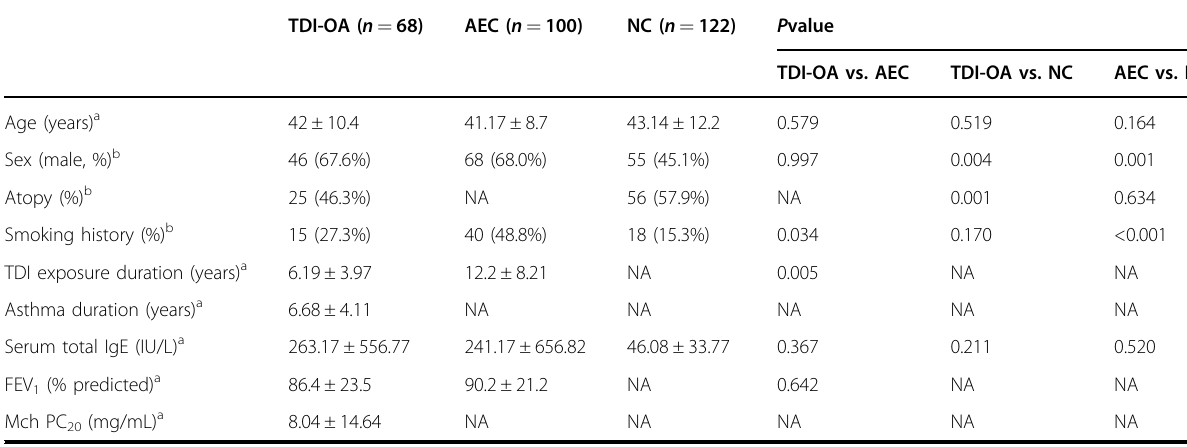
Table 1 Clinical characteristics of the study